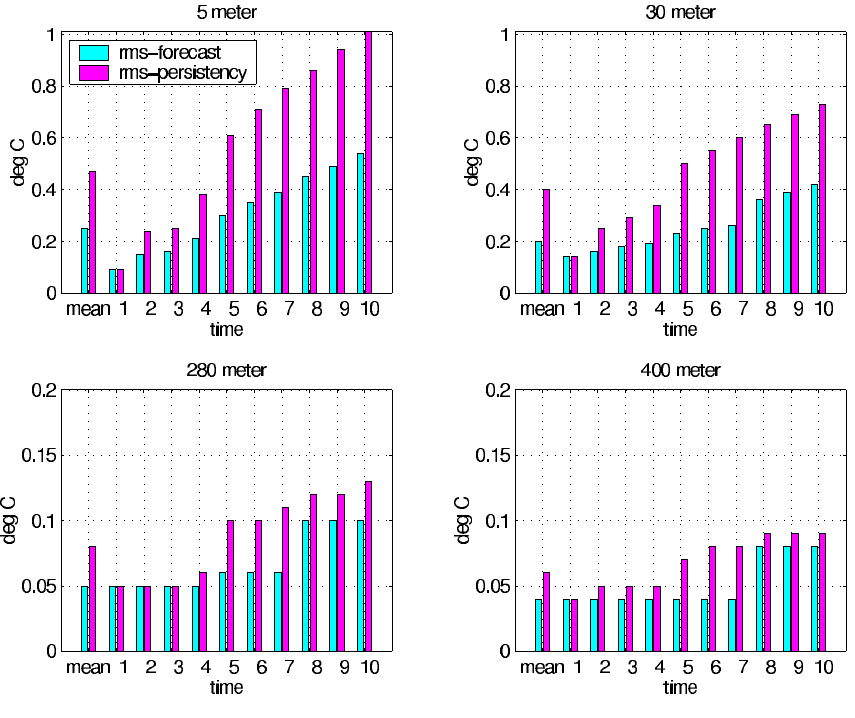
Fig. 10. Average root mean square tem- perature forecast (blue bars) and persis- tence (red bars) errors at (a) 5 m; (b) 30 m; (c) 280 m and (d) 400 m. The aver- age is carried out over the 31 forecasts done from April to October